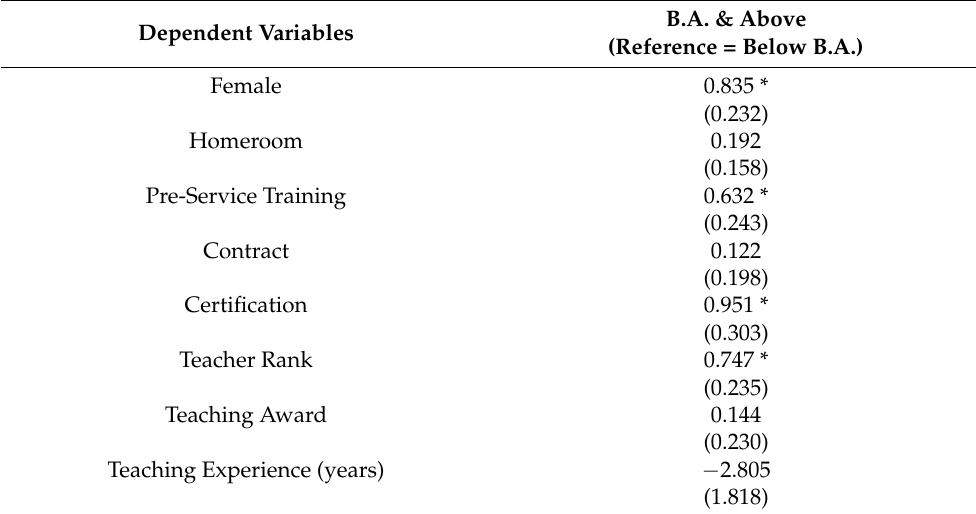
Table 5. Teacher characteristics by educational attainment (N = 253).